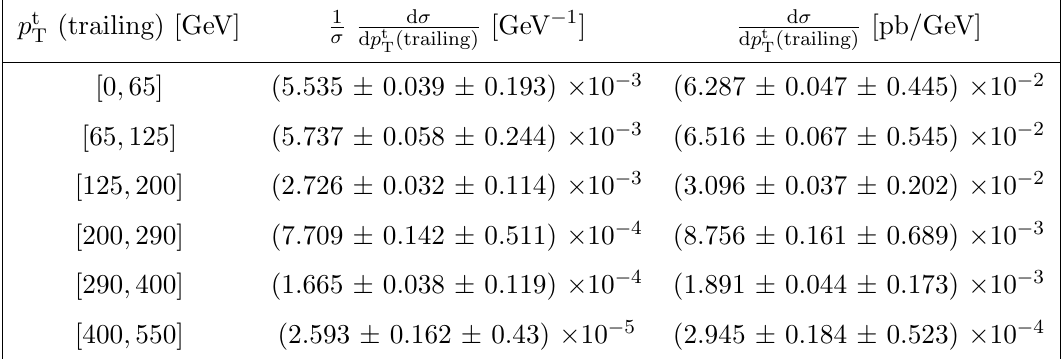
Table 18 . The measured di(cid:11)erential cross section and bin boundaries for each bin of the normalized and absolute measurements of the tt di(cid:11)erential cross section at particle level in the (cid:12)ducial phase space as a function of p t (trailing) are tabulated. T